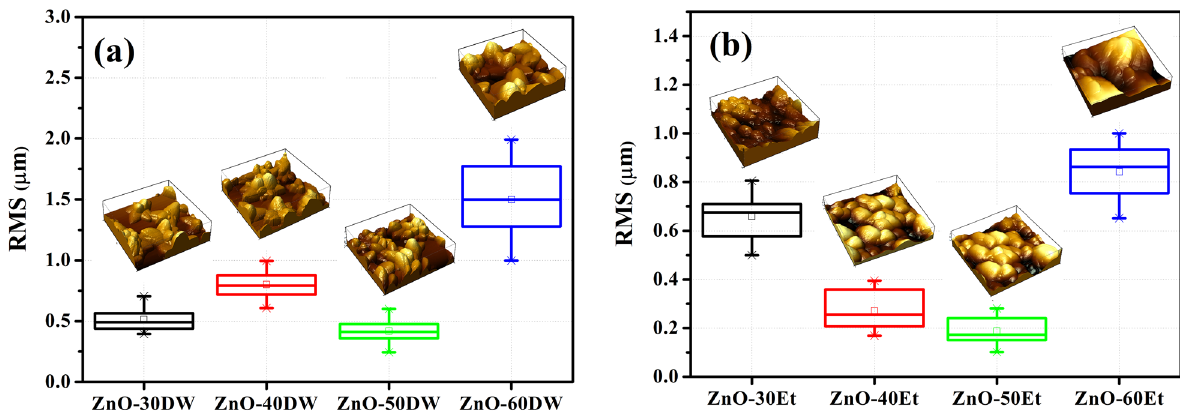
Figure 5. RMS values of the ZnO films grown in ( a ) DW and ( b ) ethanol solutions. Insets are corresponding AFM 3D